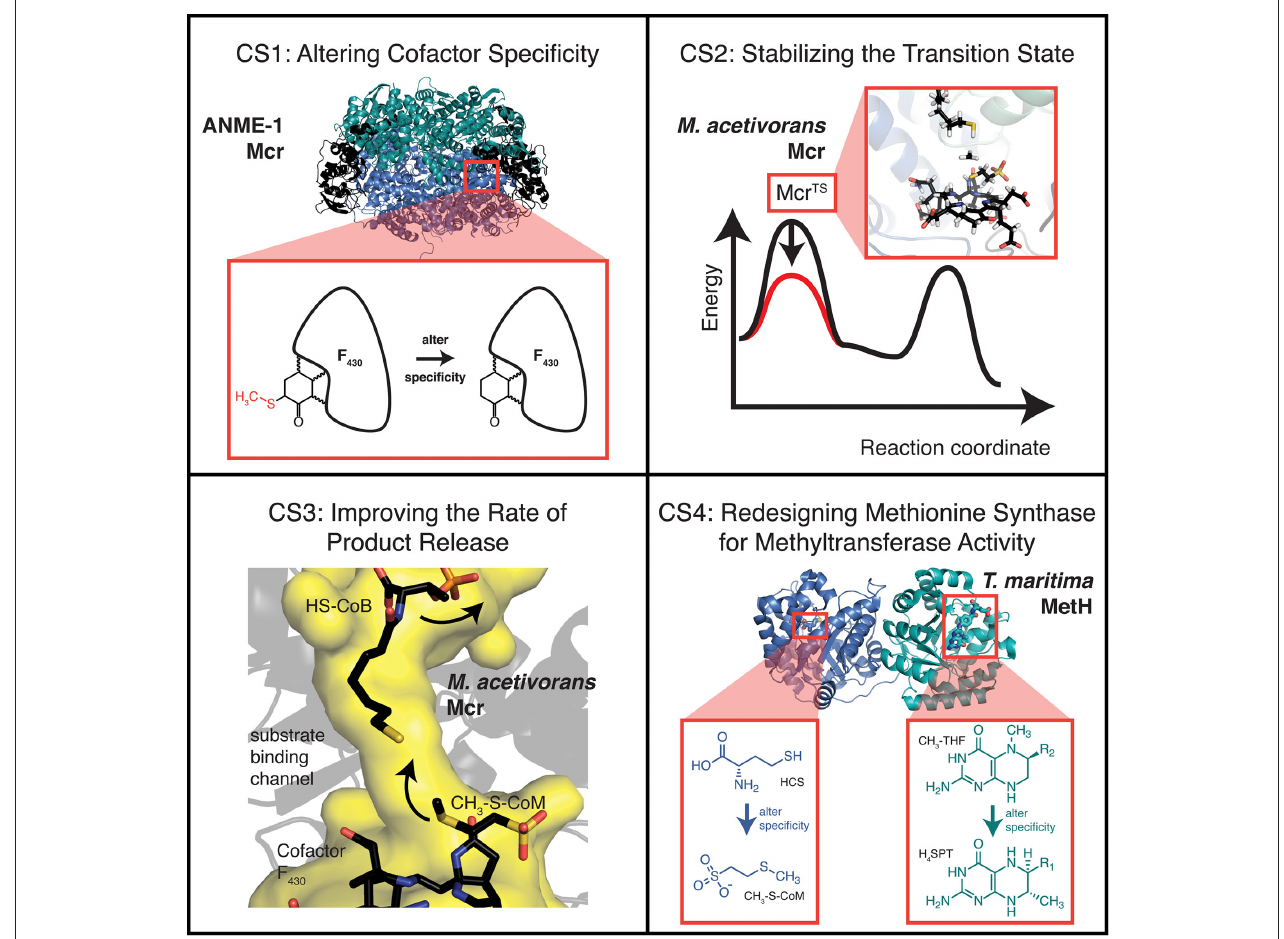
FIGURE 1 | Overview of the various case studies examined for improving AOM activity. Substrate, intermediate, and transition state energies for the free energy diagram shown for CS2 are taken from density functional theory calculations (Chen et al., 2012). The substrate abbreviations for CS4 are homocysteine (HCS), methyl-coenzyme M (CH 3 -S-CoM), 5-methyltetrahydrofolate (CH 3 -THF), and tetrahydrosarcinapterin (H 4 SPT).